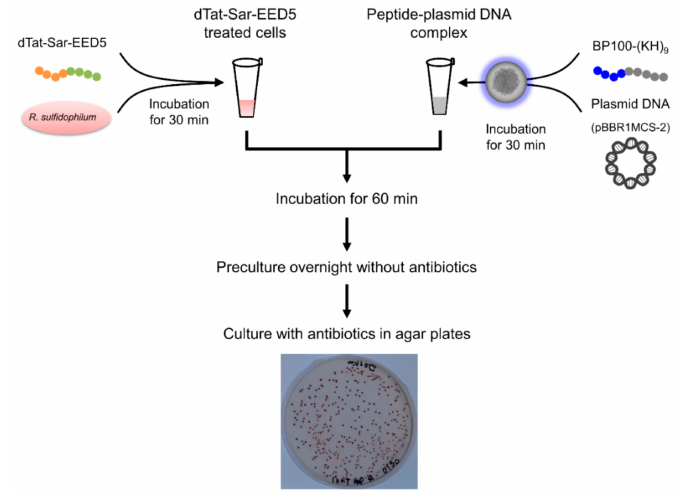
Figure 1. Procedure for the plasmid DNA delivery in this study. Cultures of R. sulfidophilum were washed and suspended with water. Washed cells were mixed with dTat-Sar-EED5 and incubated for 30 min. The plasmid DNA was mixed with BP100-(KH) 9 peptide and incubated at room temperature for 30 min to form pDNA complexes. The pDNA complex was mixed with dTat-Sar-EED5 treated cells and incubated for 60 min. Cells were cultured overnight without kanamycin. On the next day, cell cultures were spread in agar plates containing kanamycin and cultured at 30 ◦ C under the far-red light.